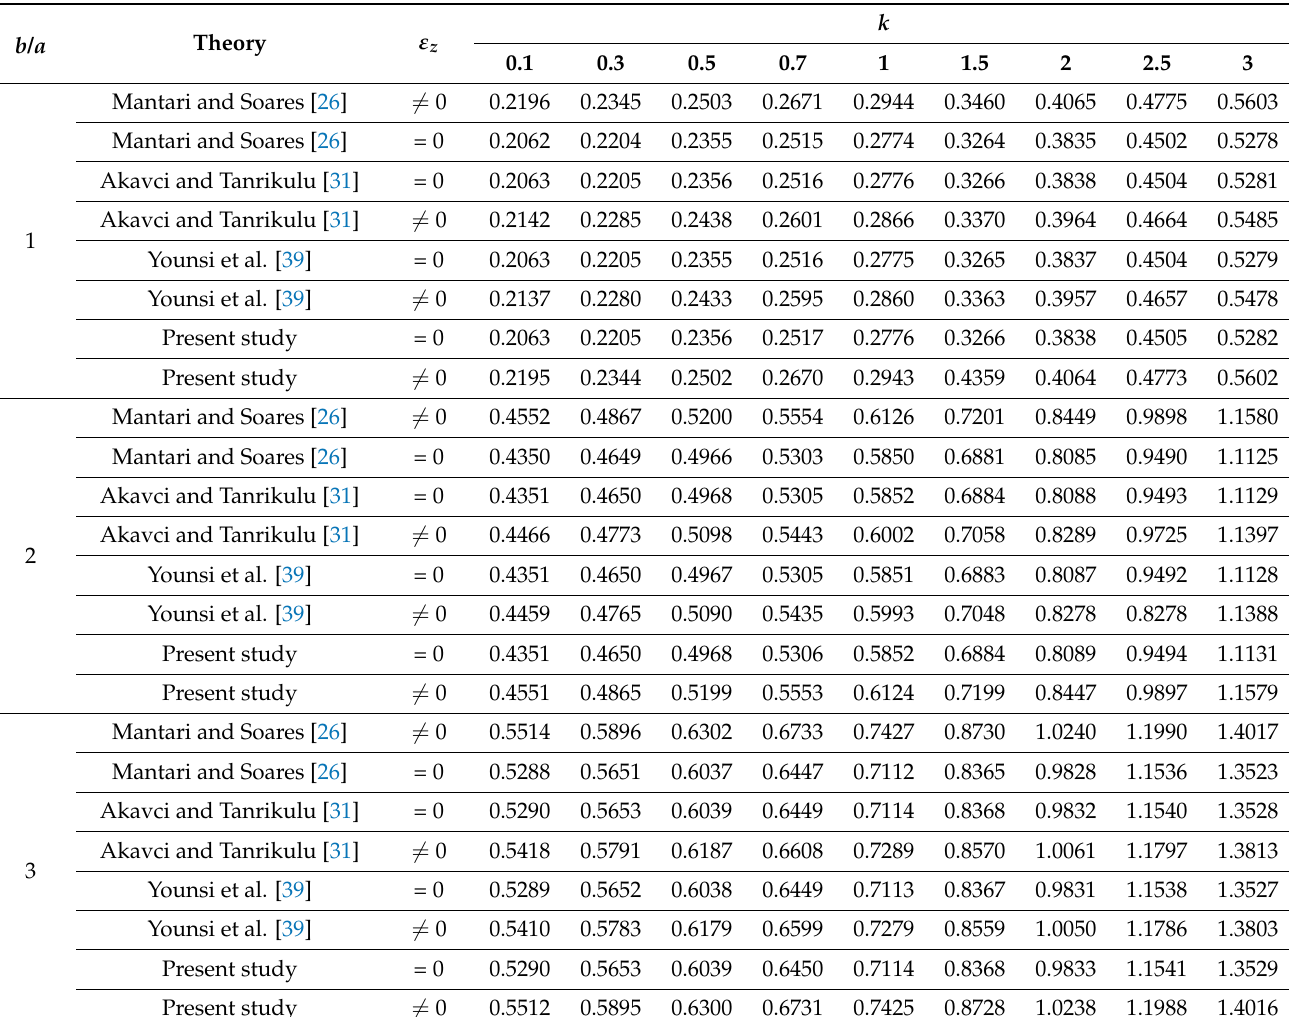
Table 5. Non-dimensional stress σ x distributed load ( a / h =